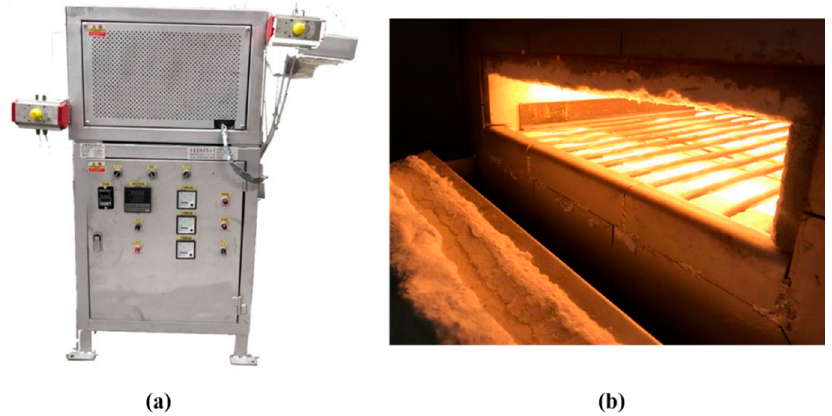
Figure 2. Photographs of infrared (IR) heat treatment apparatus: ( a ) IR heating apparatus, ( b ) heating space of the IR heating